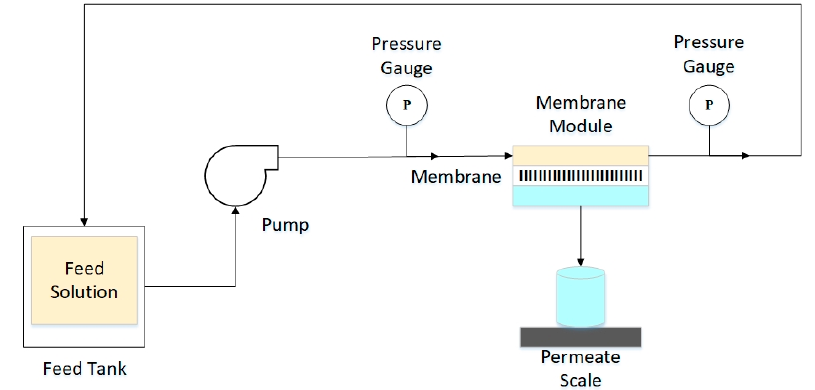
Figure 1. Crossflow membrane filtration system.